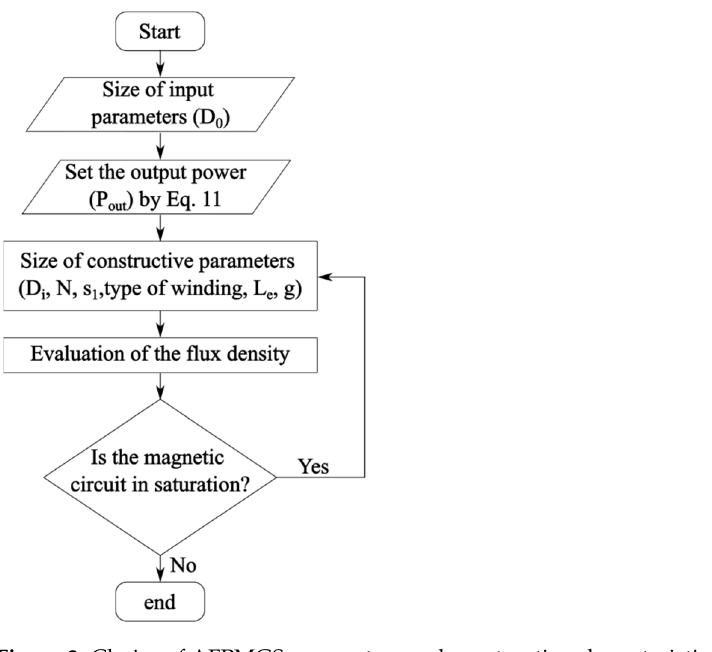
Figure 2. Choice of AFPMGS parameters and constructive characteristics.